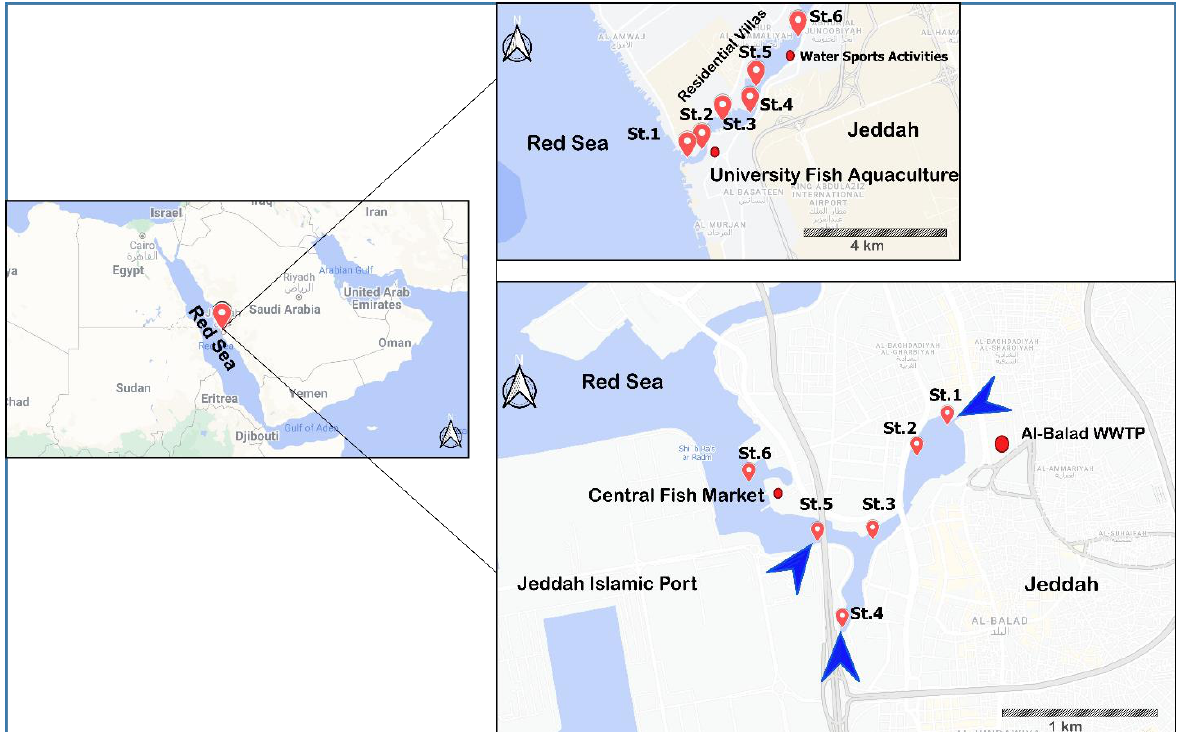
Figure 1. Al-Arbaeen and Sharm Obhur Lagoons, the eastern part of the Red Sea, samples collection sites, and the wastewater dumping points (blue arrows) of